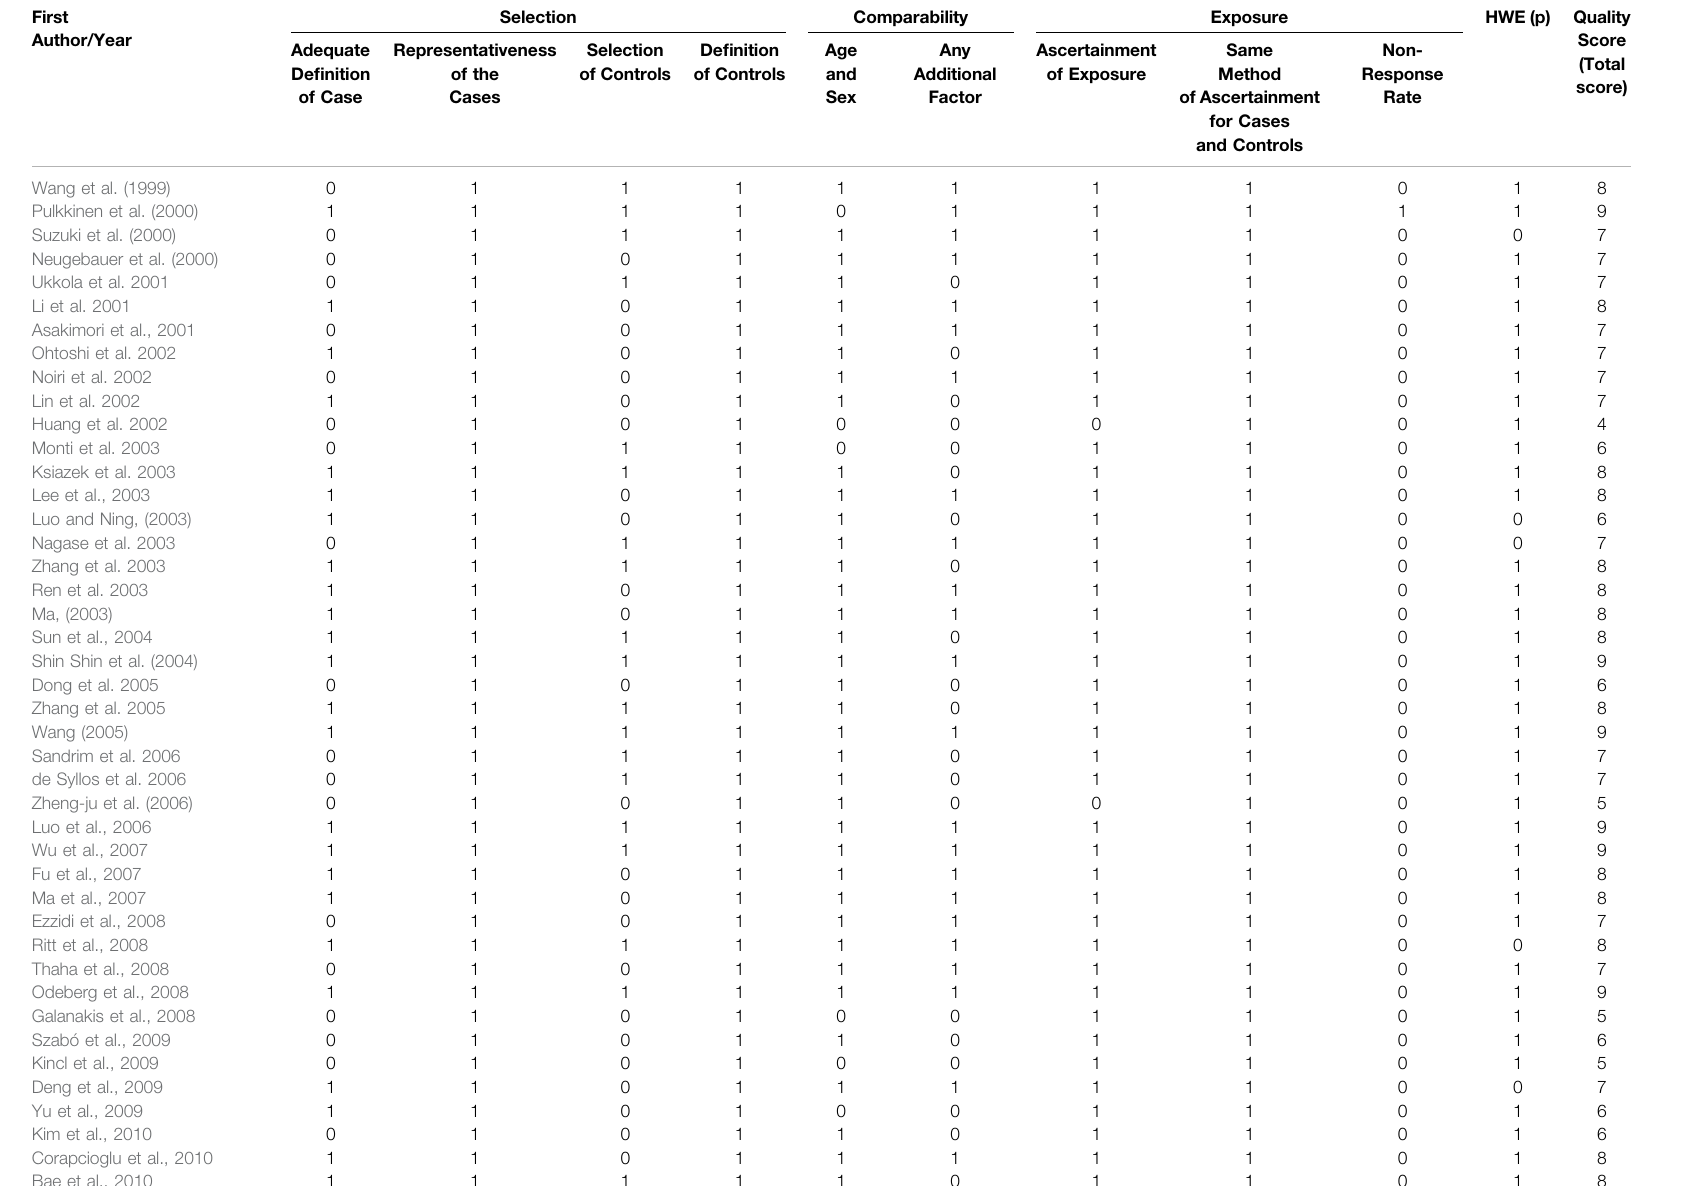
TABLE 5 | Quality assessment of included studies based on the Newcastle-Ottawa Scale for assessing the quality of case control